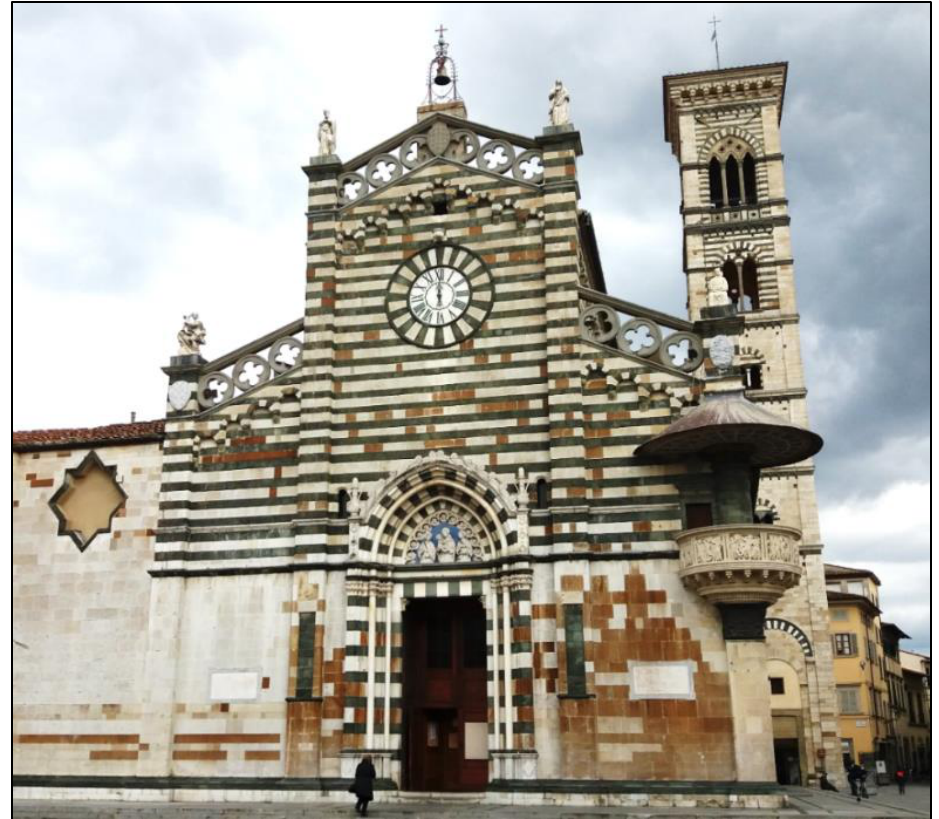
Figure 5. Façade of Prato’s Cathedral with all the types of building stones used: green Verde Prato, grey Pietra Serena, white Alberese, brownish Palombino. The pulpit parament is Carrara marble.